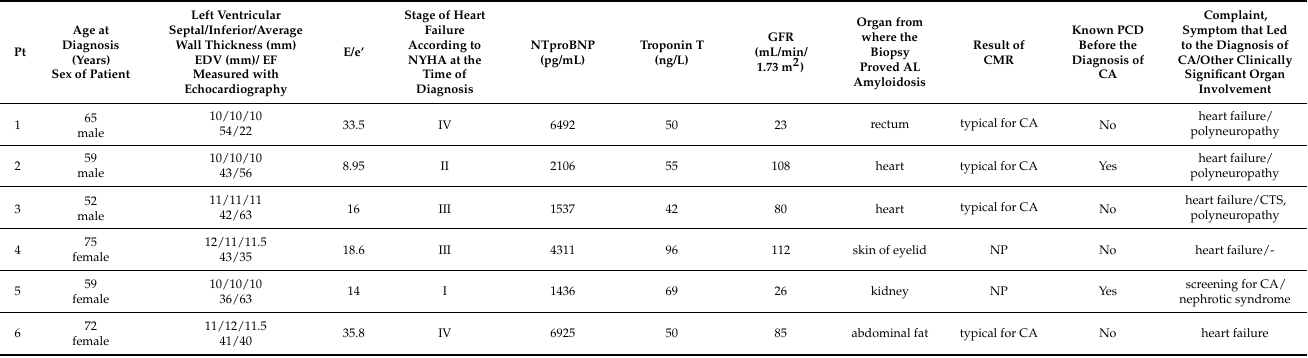
Table 2. Clinical, laboratory and echocardiographic features of patients with cardiac amyloidosis, where the average of septal and inferior wall thickness was less than 12 mm. All patients had light chain amyloidosis.